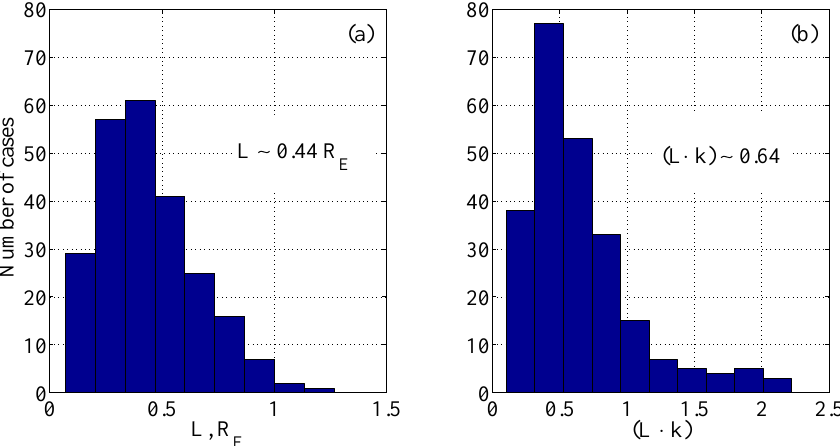
Figure 5. (a) The statistics of CS thickness L , calculated by B 0 and j tmg for each CS crossing. (b) The distribution kL for CS thickness L and wavevector k .